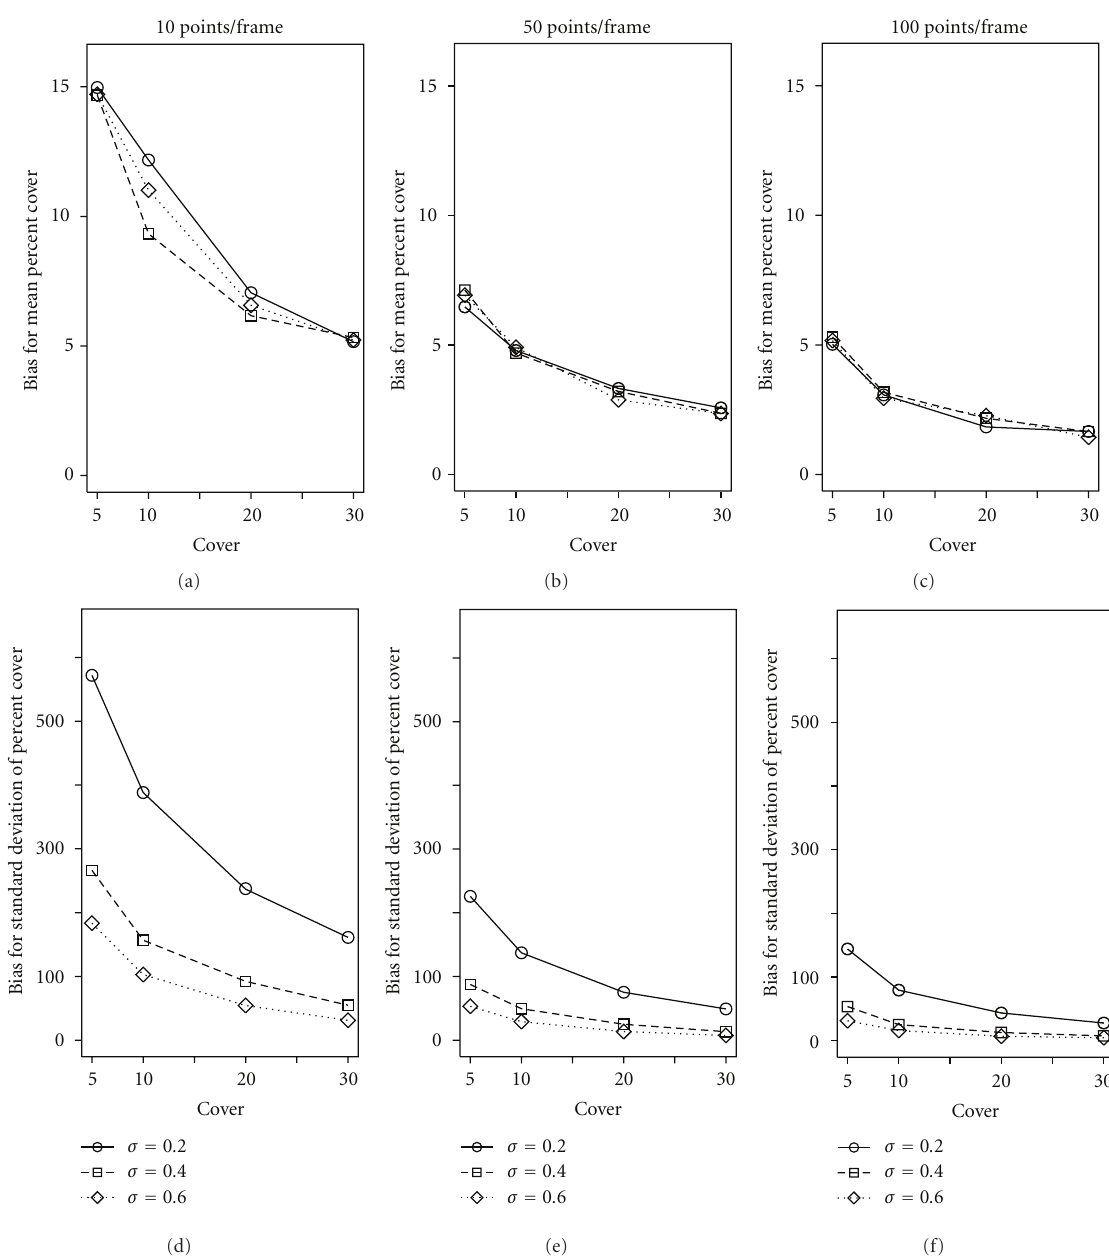
Figure 4: Bias of the estimated mean cover (a)–(c) and standard deviation of mean cover (d)–(f), based on 100 replicated simulations.